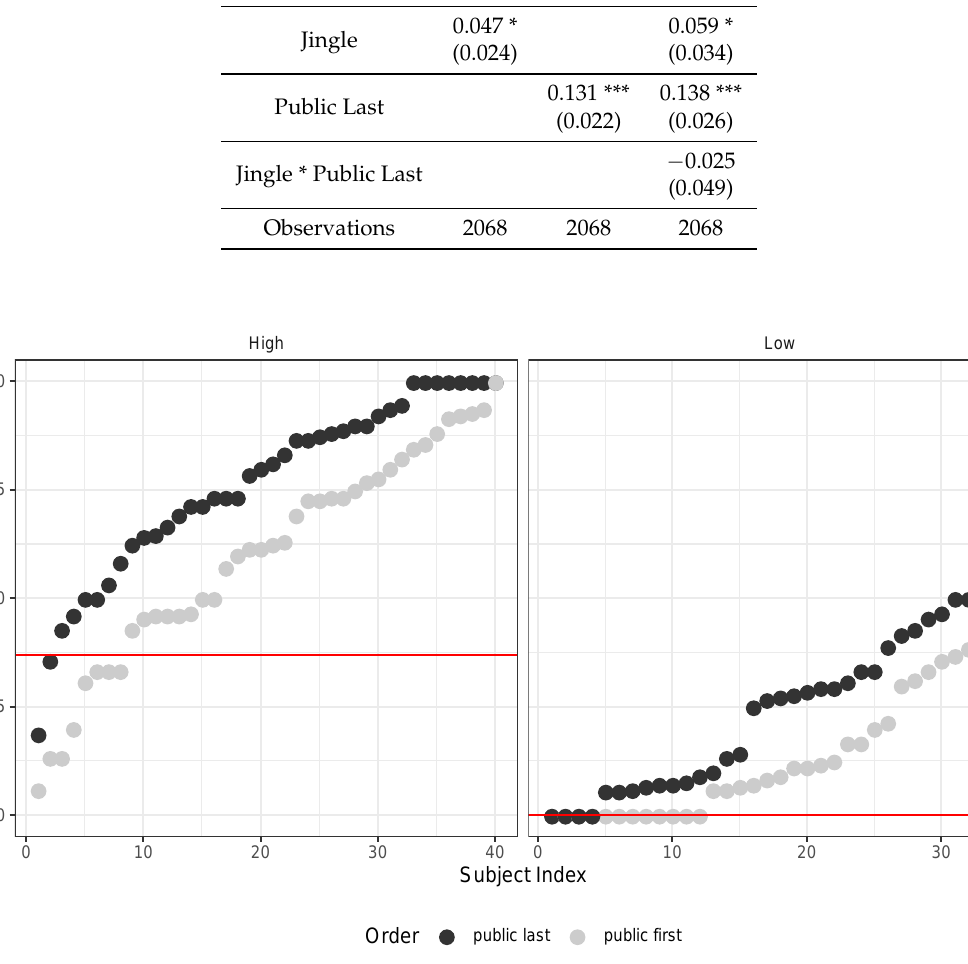
Figure 6. Individual average treatment effect of recency. Each dot represents the proportion of rounds an individual votes with the public signal under mismatch. Dark dots correspond to when the public signal is more recent, light dots when the private is more recent. Horizontal lines represent the symmetric responsive equilibrium predictions for µ . Recency has a positive, constant effect across different